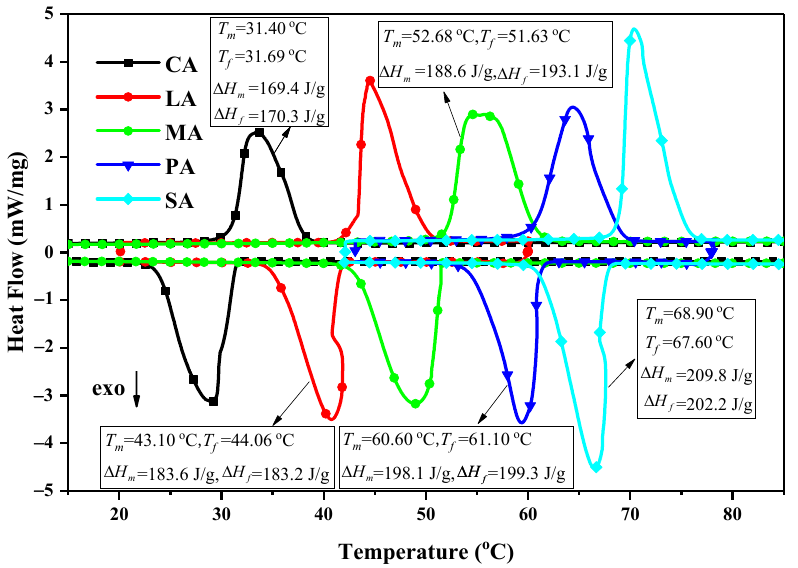
Figure 1. DSC curves of five pure fatty acids.